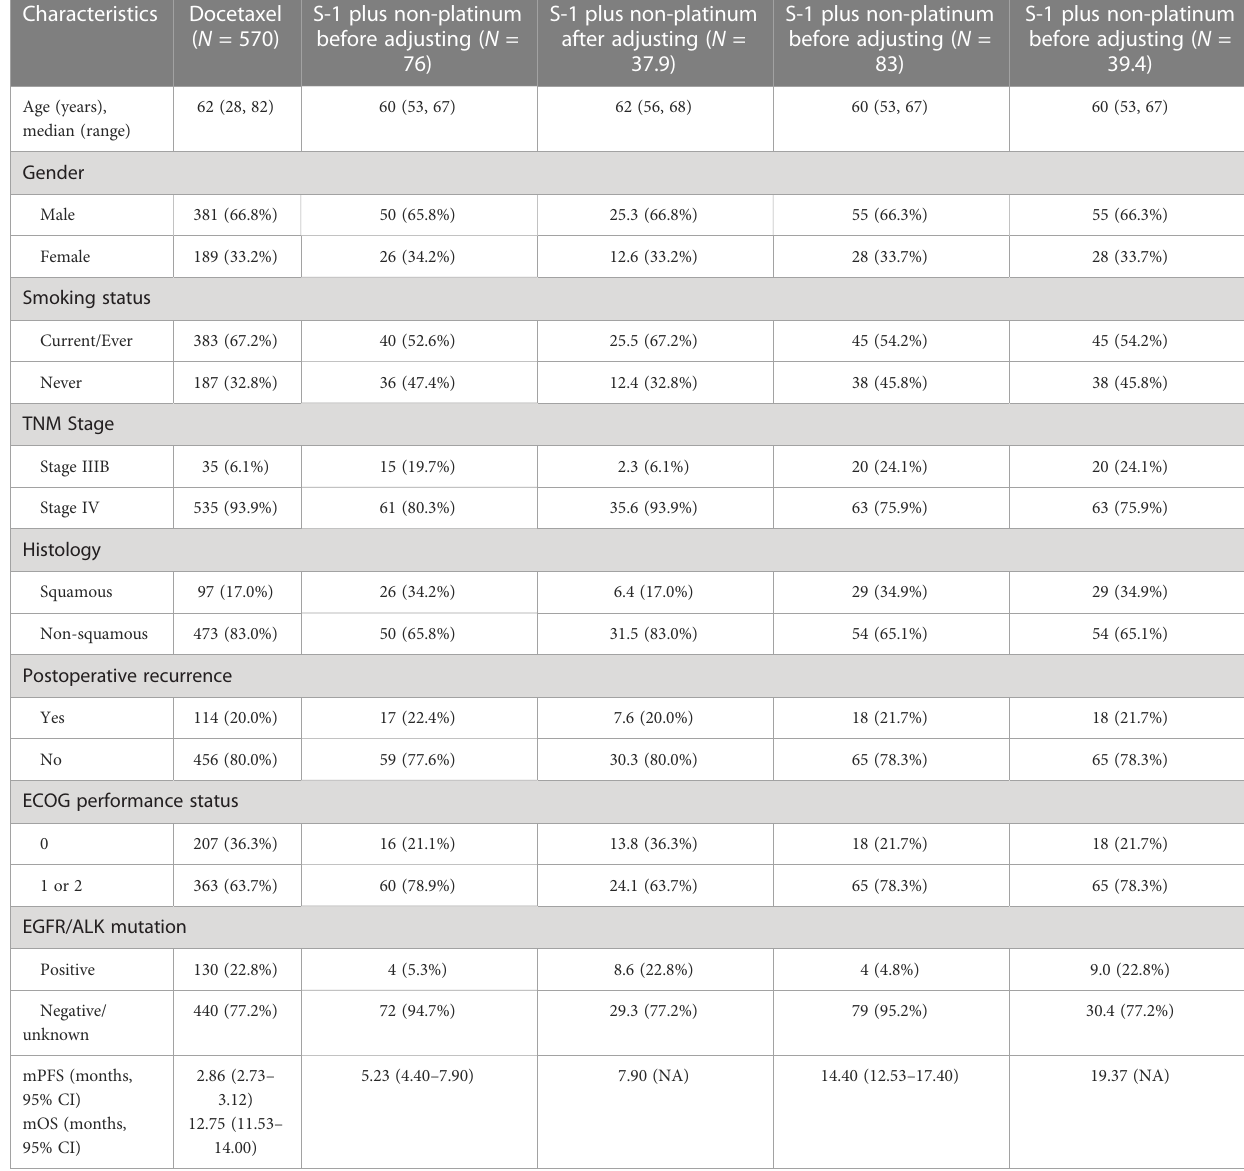
TABLE 4 Indirect adjustment of PFS and OS by weight